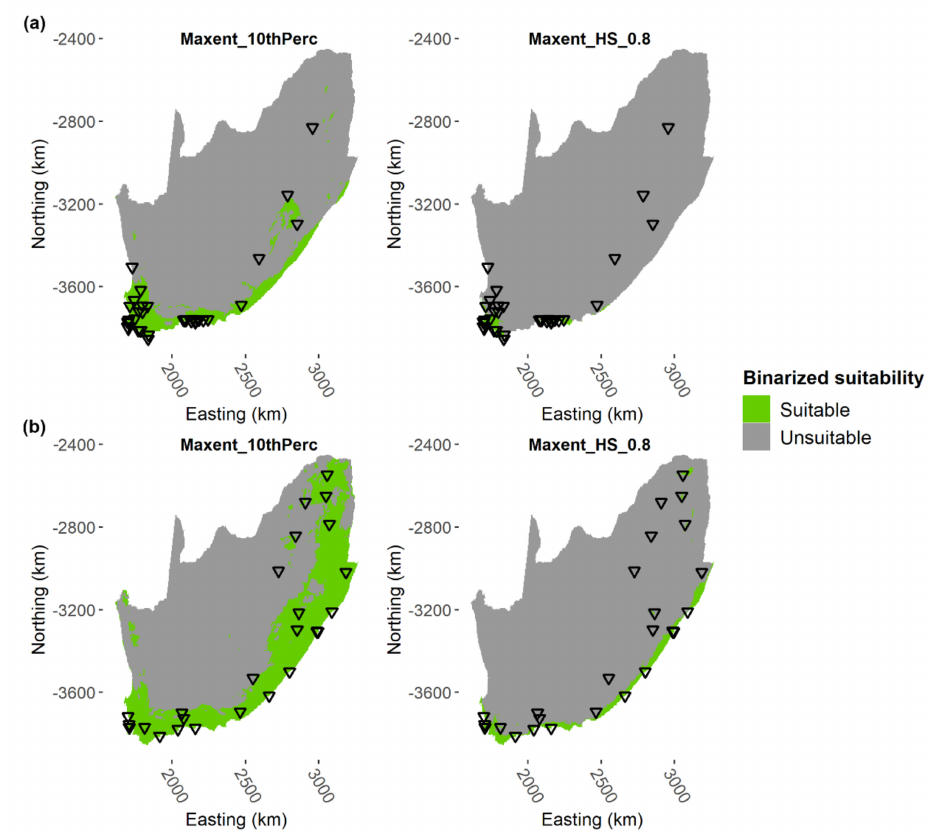
Figure 7. Binarized suitability resulting from the conversion of the Maxent-derived weighted av- erage habitat suitability (Wgt_Avg HS) to binary predictions based on 10th percentile training threshold (left maps) or on a threshold corresponding to Wgt_Avg HS ≥ 0.8 (right maps), for: ( a ) Chaetocnema darwini ; ( b ) C. natalensis . Reversed black-contoured triangles indicate the species’ occurrence